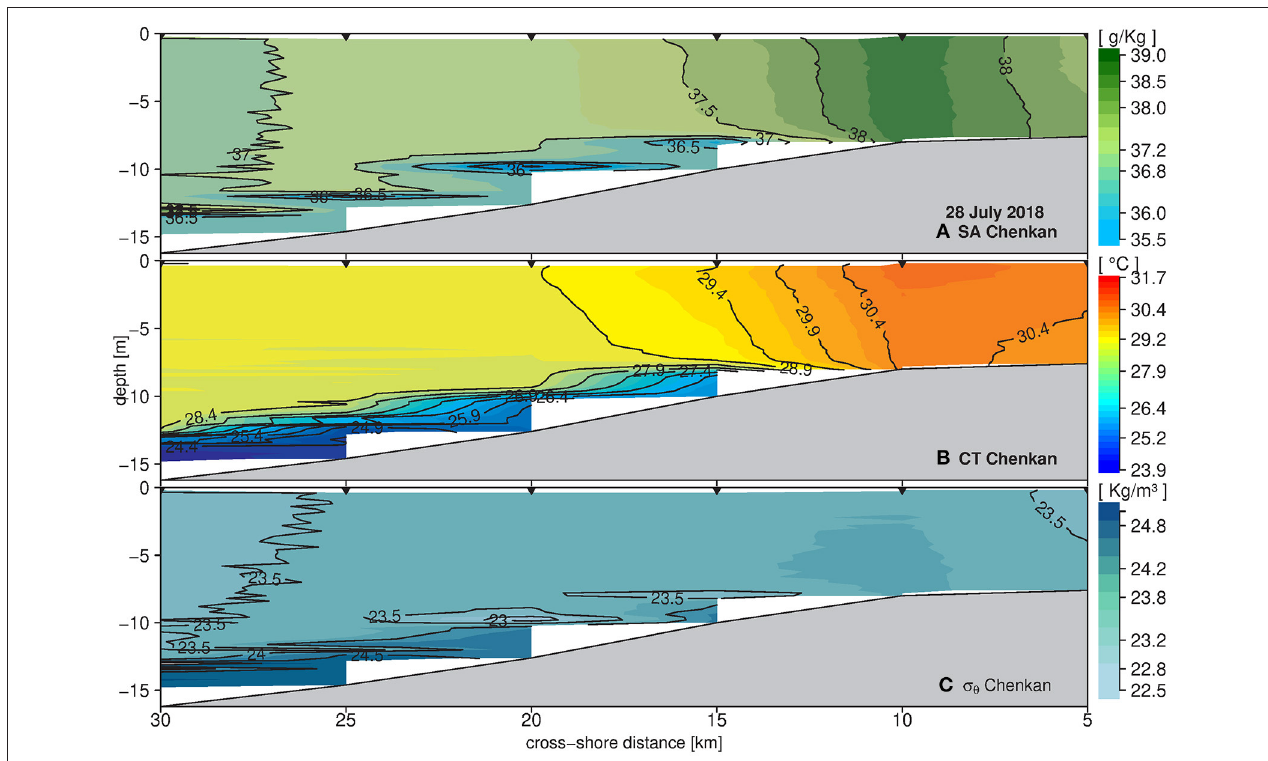
FIGURE 5 | Cross-shore view of the vertical distribution of (A) absolute salinity (g/Kg), (B) conservative temperature ( ◦ C), and (C) density ( σ θ in kg/m3), off Chenkan locality (L1 on Figure 1 ). Black triangles on top depict sampling stations. This figure represents the observations taken during July 28, 2018.